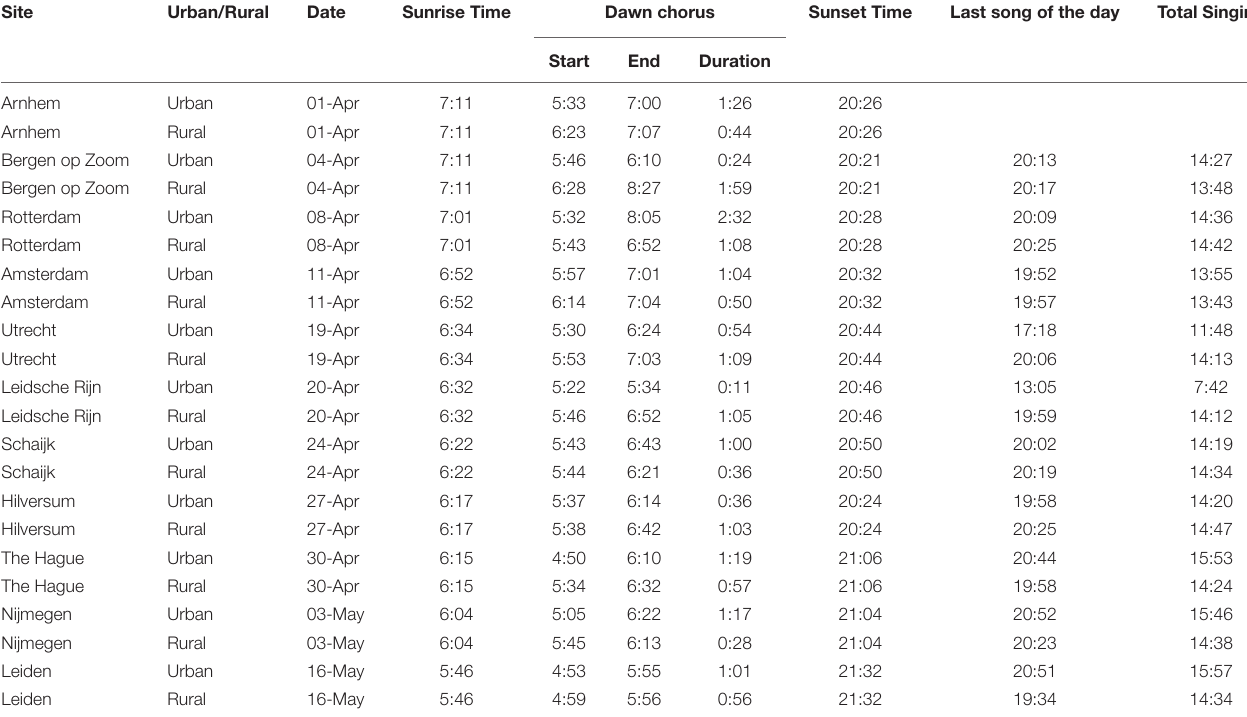
TABLE 1 | Urban and rural pairs of sites and information about the date of recording, sunrise time (from https://cdn.knmi.nl), dawn chorus start, end and duration time, sunset time, last song of the daytime and total singing